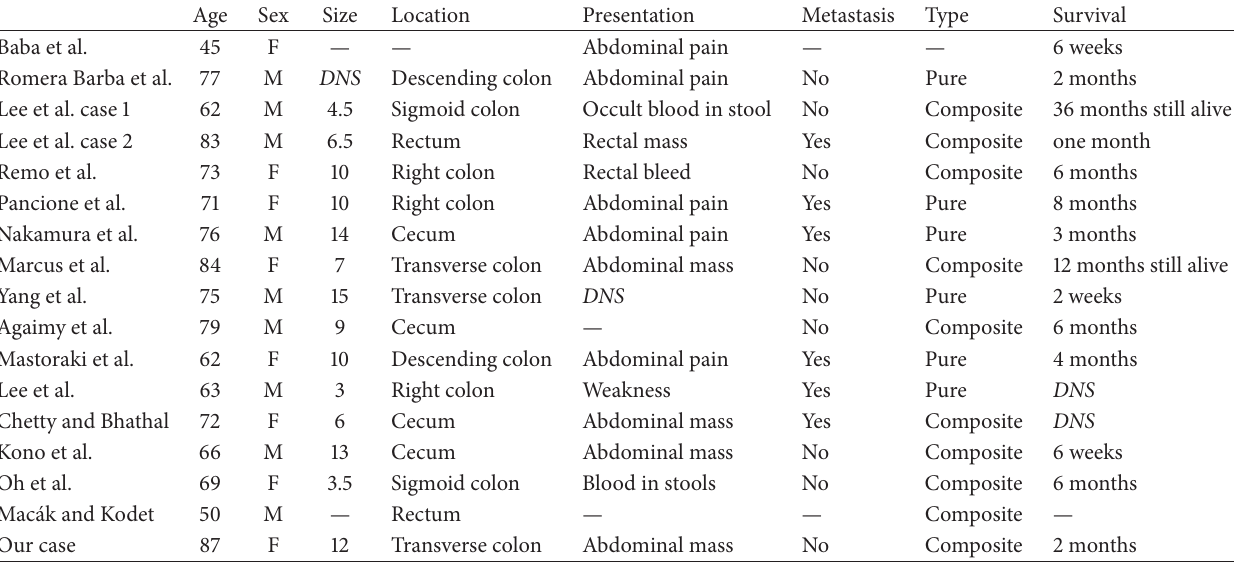
Table 2: Clinical characteristics of all cases of poorly differentiated carcinoma of the colon with rhabdoid features described in the literature, to our knowledge. Age is in years. Size means the largest diameter of the tumor in centimeters. DNS: did not specify . [5–19]. Age Sex Size Location Presentation Metastasis Type Survival 45 — — Abdominal pain — — 6 weeks M DNS Descending colon Abdominal pain No Pure 62 M 4.5 Sigmoid colon Occult blood in stool No Composite 36 months still alive 83 M 6.5 Rectum Rectal mass Yes Composite one month 73 F 10 Right colon Rectal bleed No Composite 6 months 10 Right colon Abdominal pain Yes Pure 14 Cecum Abdominal pain Yes Pure 84 F 7 Transverse colon Abdominal mass No Composite Transverse colon Pure Cecum — No Composite Mastoraki et al. 62 F 10 Descending colon Abdominal pain Yes Pure 4 months Right colon Weakness Yes Pure Cecum Abdominal mass Yes Composite DNS Cecum Abdominal mass No Composite 3.5 Sigmoid colon Blood in stools No Composite Rectum Composite Transverse colon Abdominal mass No